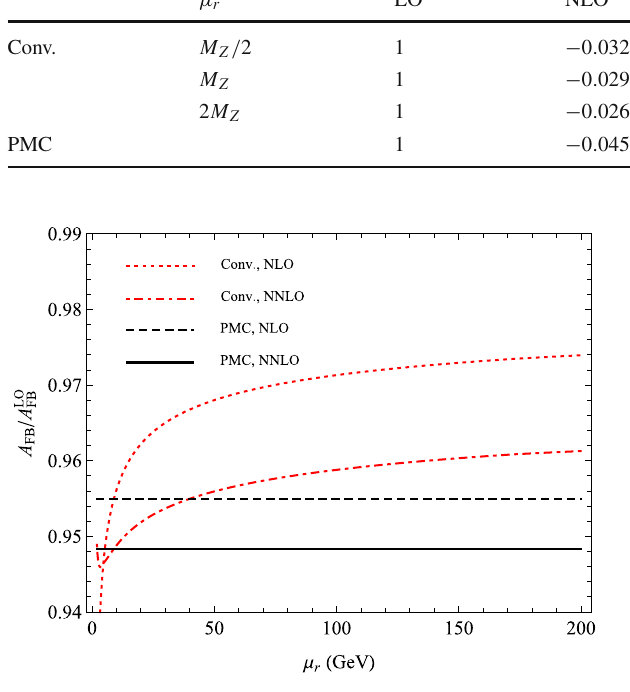
Fig. 2 The QCD correction factors A FB / A LO versus the renormaliza- FB tion scale μ r for the b quark forward–backward asymmetry with the quark axis definition using the conventional (Conv.) and PMC scale set- tings, where the dashed and solid lines stand for the PMC predictions up to the NLO and NNLO level, respectively; the dotted and dot–dashed lines are the corresponding results for conventional scale settings. The renormalization scale μ r is changed in a wide range of μ r ∈ [2 GeV, 200